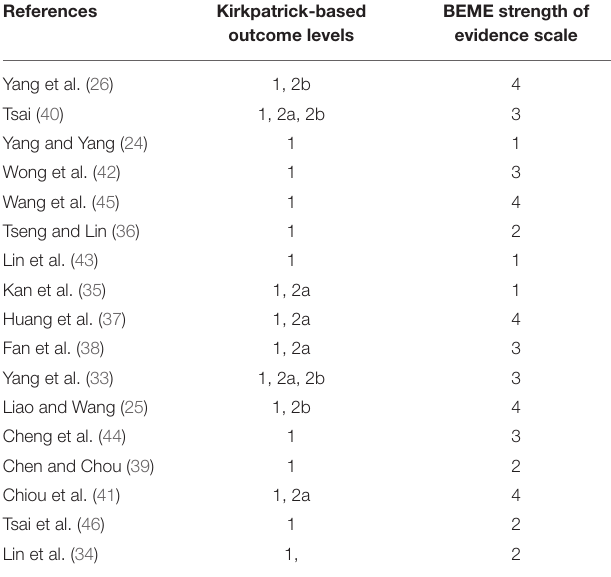
TABLE 4 | Quality of evidence and evidence of measurable